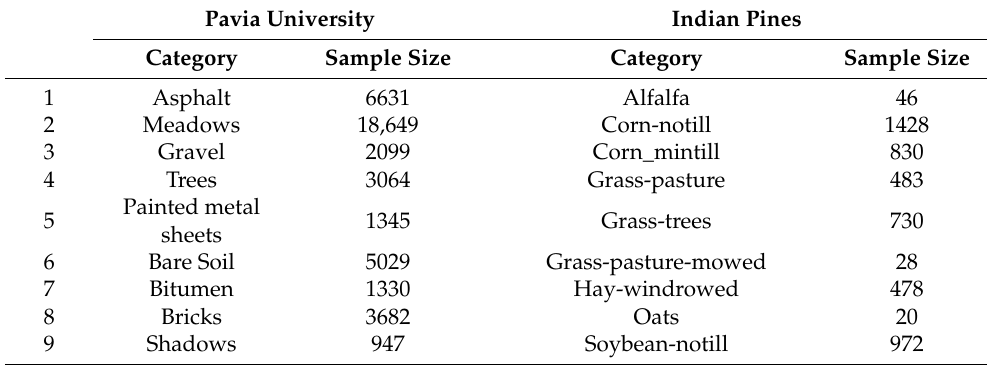
Figure 3. Indian Pines dataset diagram. The left is a pseudo-color map, and the right is a true feature category map. Table 1. Features of